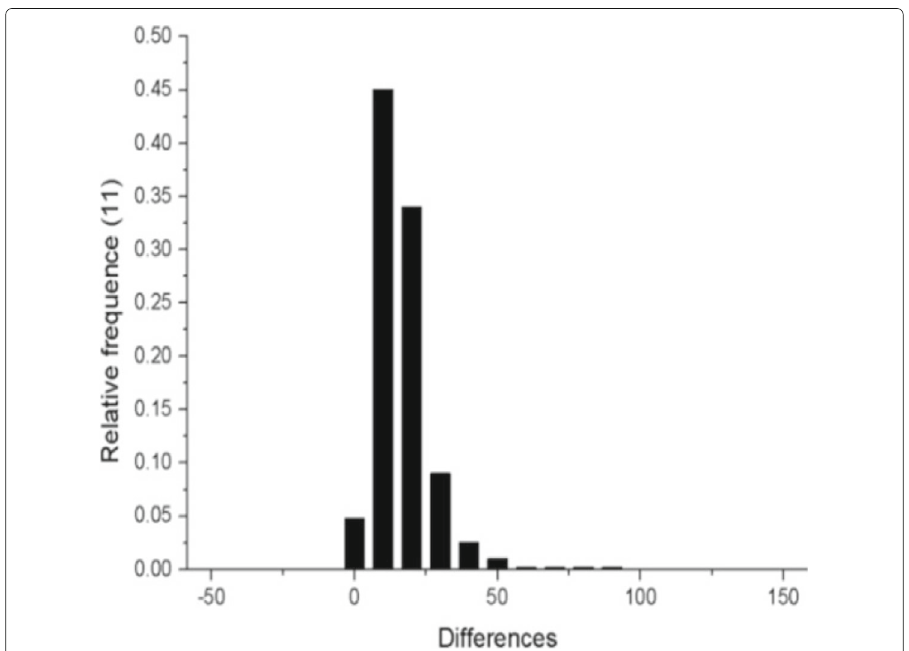
Fig. 3 The difference between exact counting and probabilistic counting of Count-Min